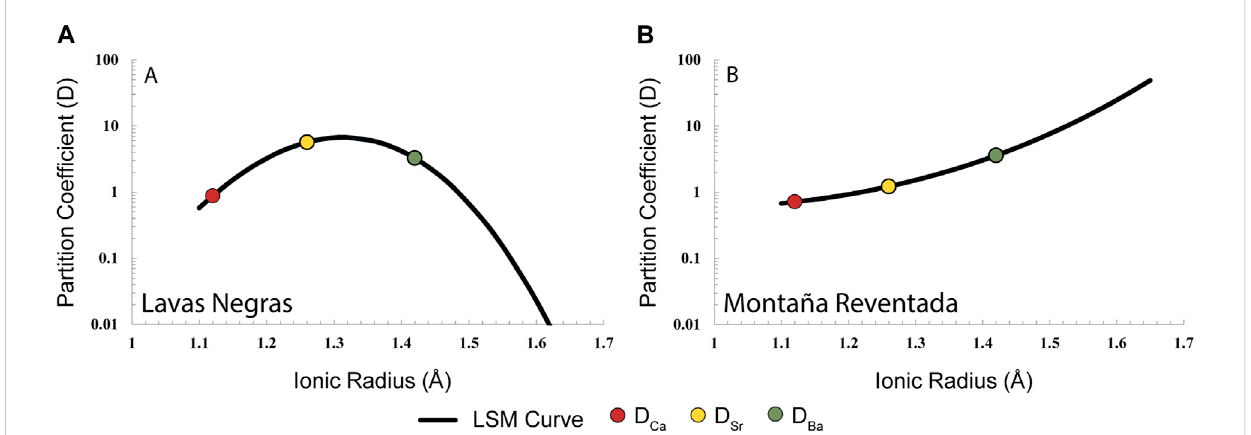
FIGURE 11 Partition coef fi cient vs ionic radius curves for two feldspar/melt pairs, one in equilibrium with its host melt (A) , Lavas Negras eruption and other in disequilibrium (B) , Montaña